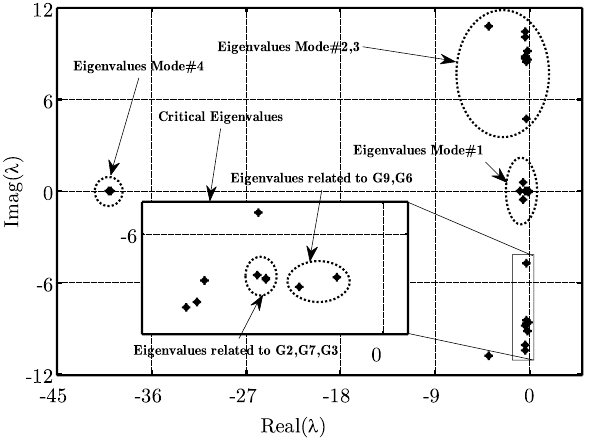
Fig. 7 Eigenvalues locus plot of IEEE 39-bus